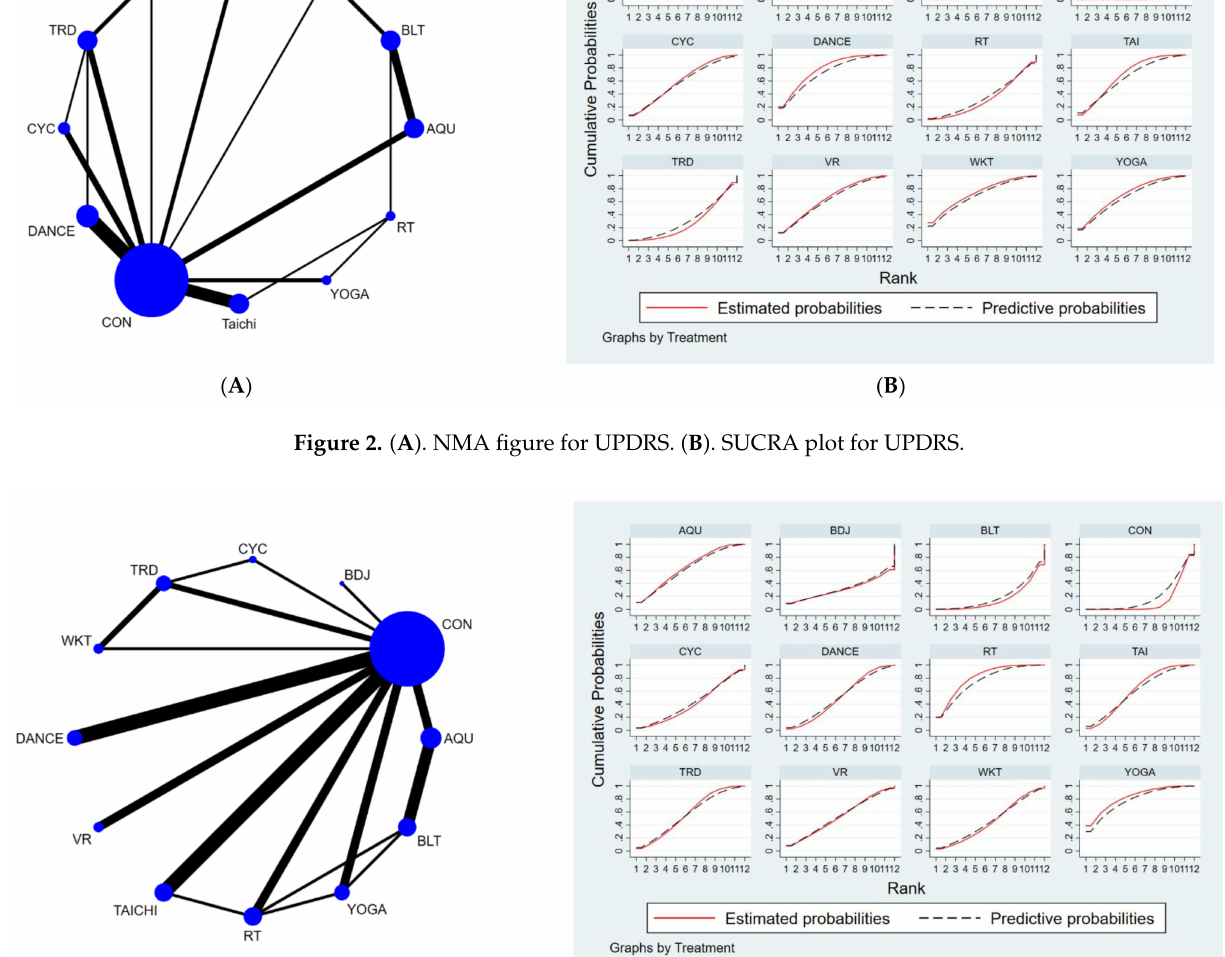
ing exercises [MD = − 4.79, 95% CI = ( − 9.05, − 0.53)], yoga exercises [MD = − 4.51, 95% CI = ( − 8.02, − 1.00)], Taijiquan practice [MD = − 4.26, 95% CI = ( − 6.63, − 1.88)], virtual reality practice [MD = − 4.12, 95% CI = ( − 7.34, − 0.91)], cycling practice [MD = − 3.70, 95% CI = ( − 6.65, − 0.75)], aquatic exercise [MD = − 2.93, CL = ( − 5.38, − 0.48)], water exercise [MD = − 2.93, 95% CI = ( − 5.38, − 0.48)] were superior to the control group in